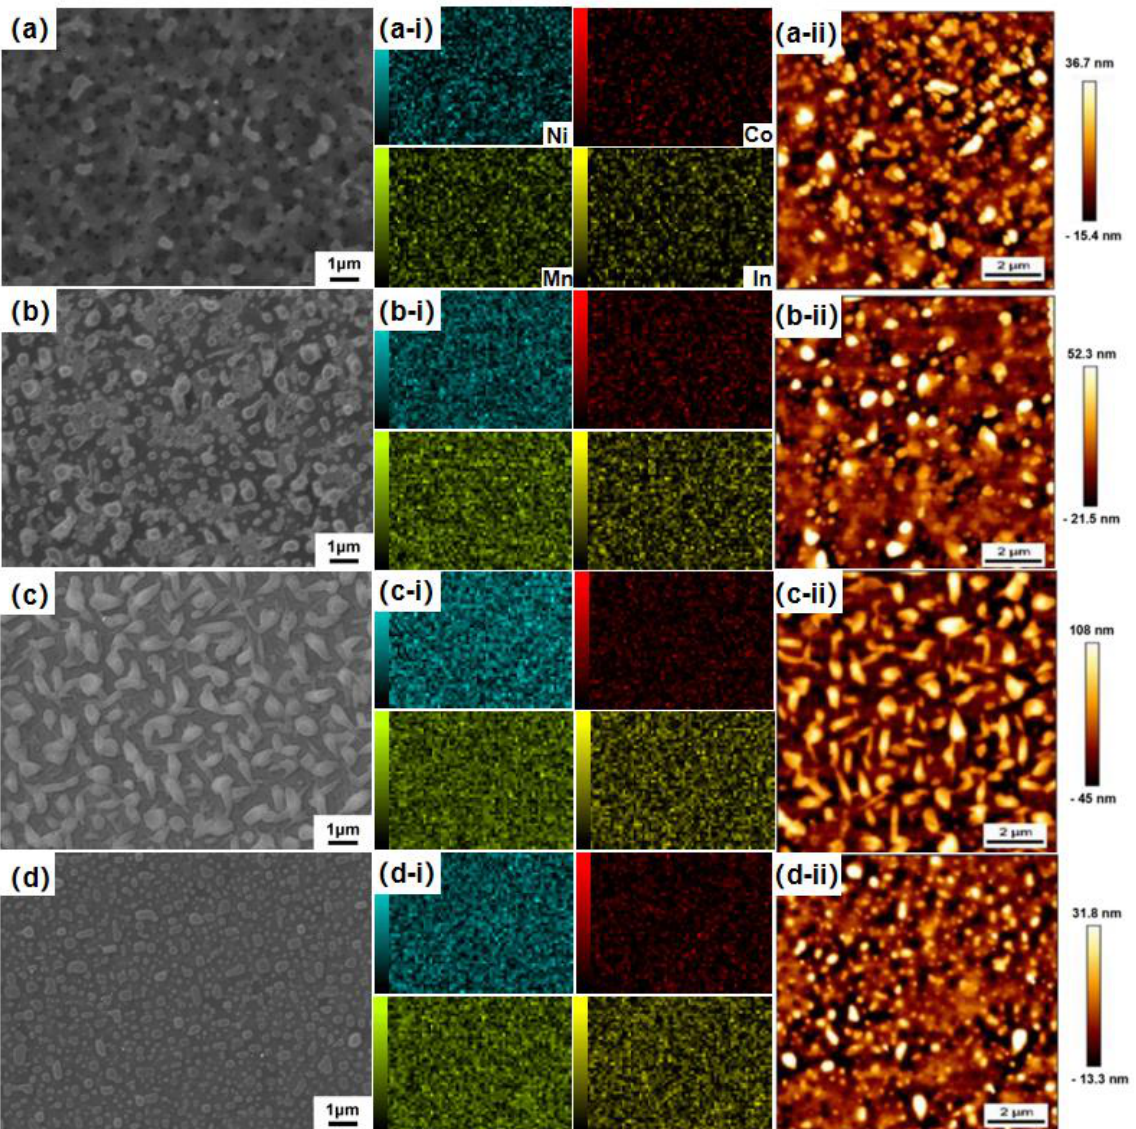
Figure 4. The surface morphology of the Ni-Co-Mn-In alloy thin films (samples label #1–#4) is characterized by SEM ( a – d ) and AFM ( a-ii )–( d-ii ). The composition uniformity of the Ni-Co-Mn-In alloy thin films (samples label #1–#4) is characterized by EDS ( a-i )–( d-i ). The M-T curves of the Ni-Co-Mn-In alloy films (#1–#4) are measured using the